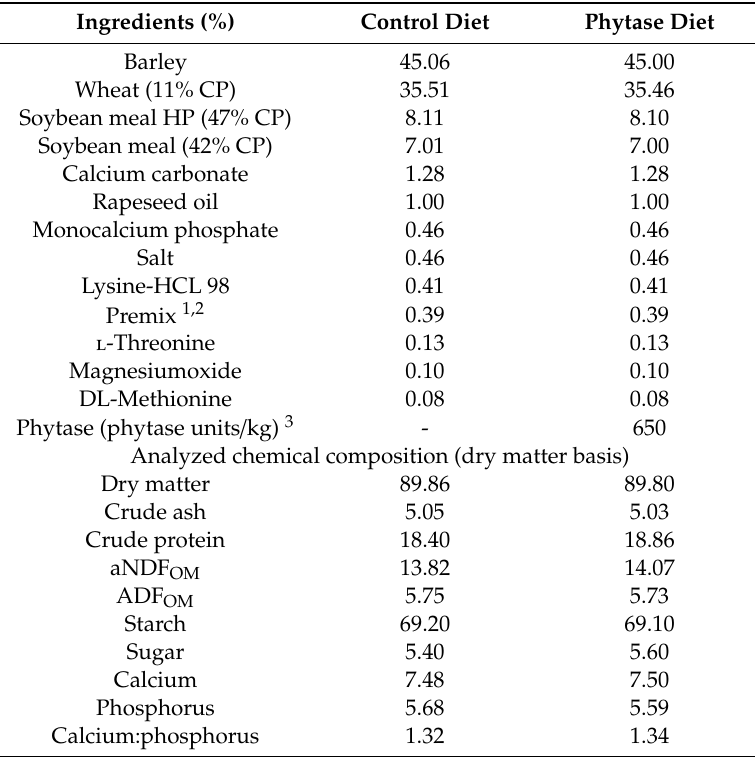
Table 1. Dietary ingredients and chemical